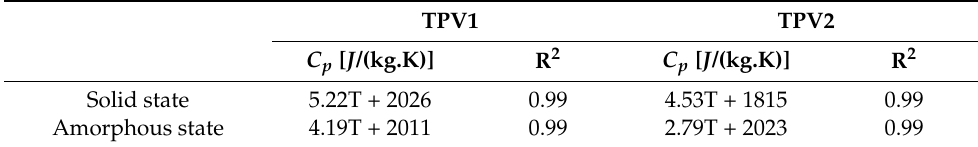
Table 5. Apparent specific heat of TPVs under study.